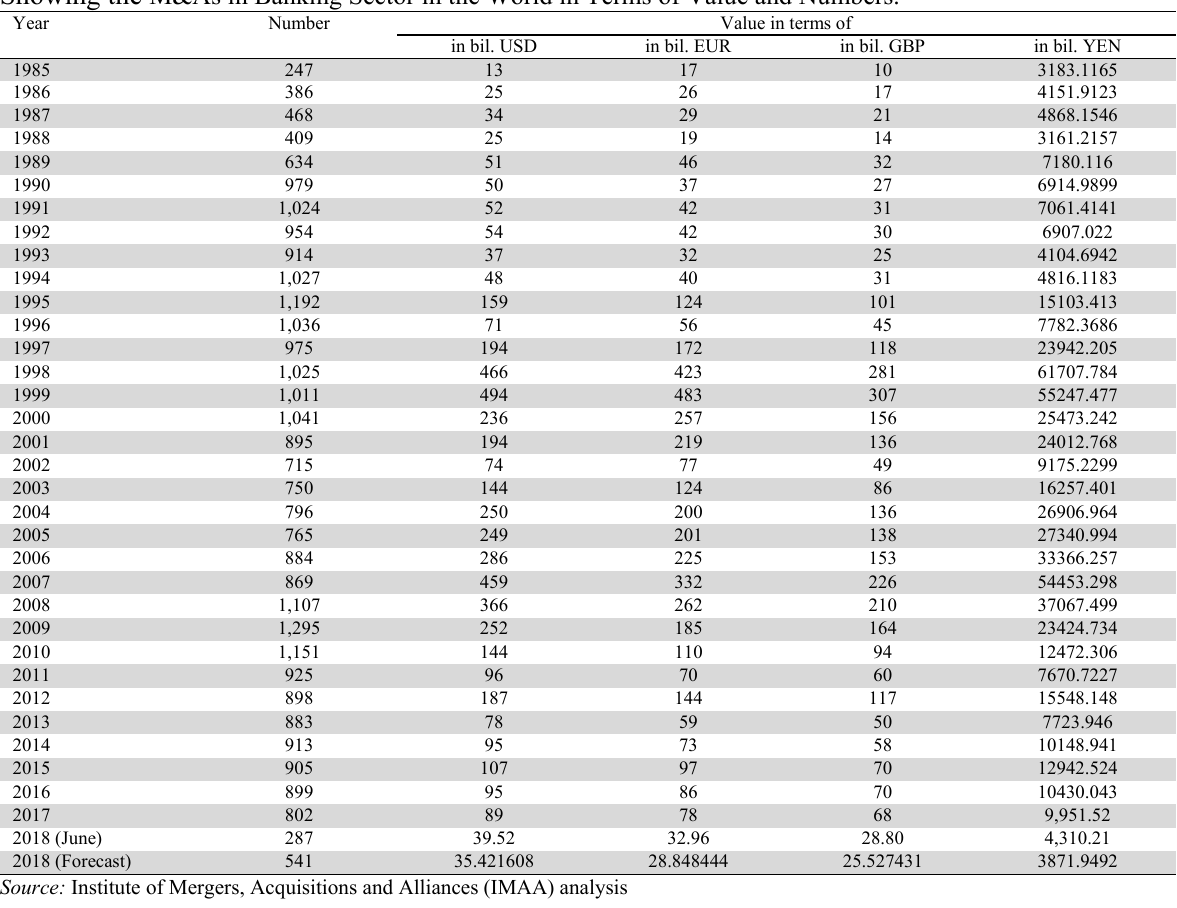
Showing the M&As in Banking Sector in the World in Terms of Value and Numbers. Year